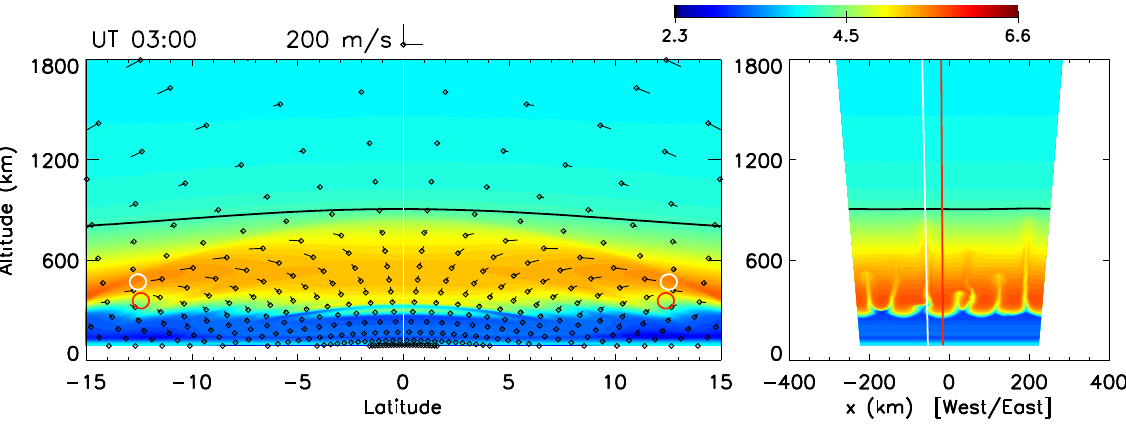
Fig. 4. Contours of log 10 n e at a fixed longitude (left) and at the magnetic equator (right). The location of the left-hand contour in the right-hand panel is indicated by a white line and vice versa. Ionization crests are indicated within the ESF plume (white circles) and in the background (red circles). A dark curve near the center of each plot indicates the H + /O + transition height. In the left hand panel, O + ion velocity vectors indicate the direction of flow away from the